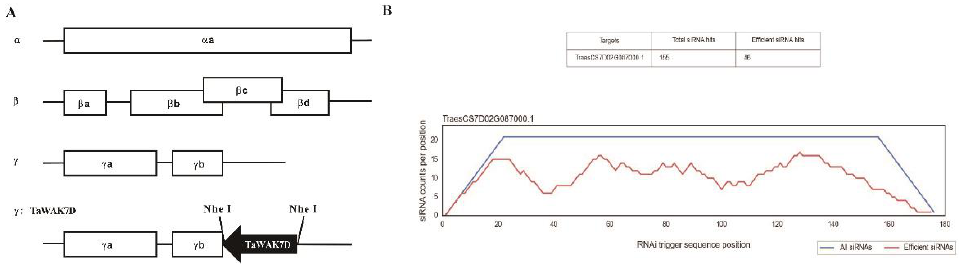
Figure 4. Schemata of recombinant BSMV:TaWAK7D construct and si-Fi software off-target prediction. ( A ) Schemata of recombinant BSMV:TaWAK7D construct. The orientation of the TaWAK7D insert is indicated by dark box. ( B ) SIFI software off-target prediction results.